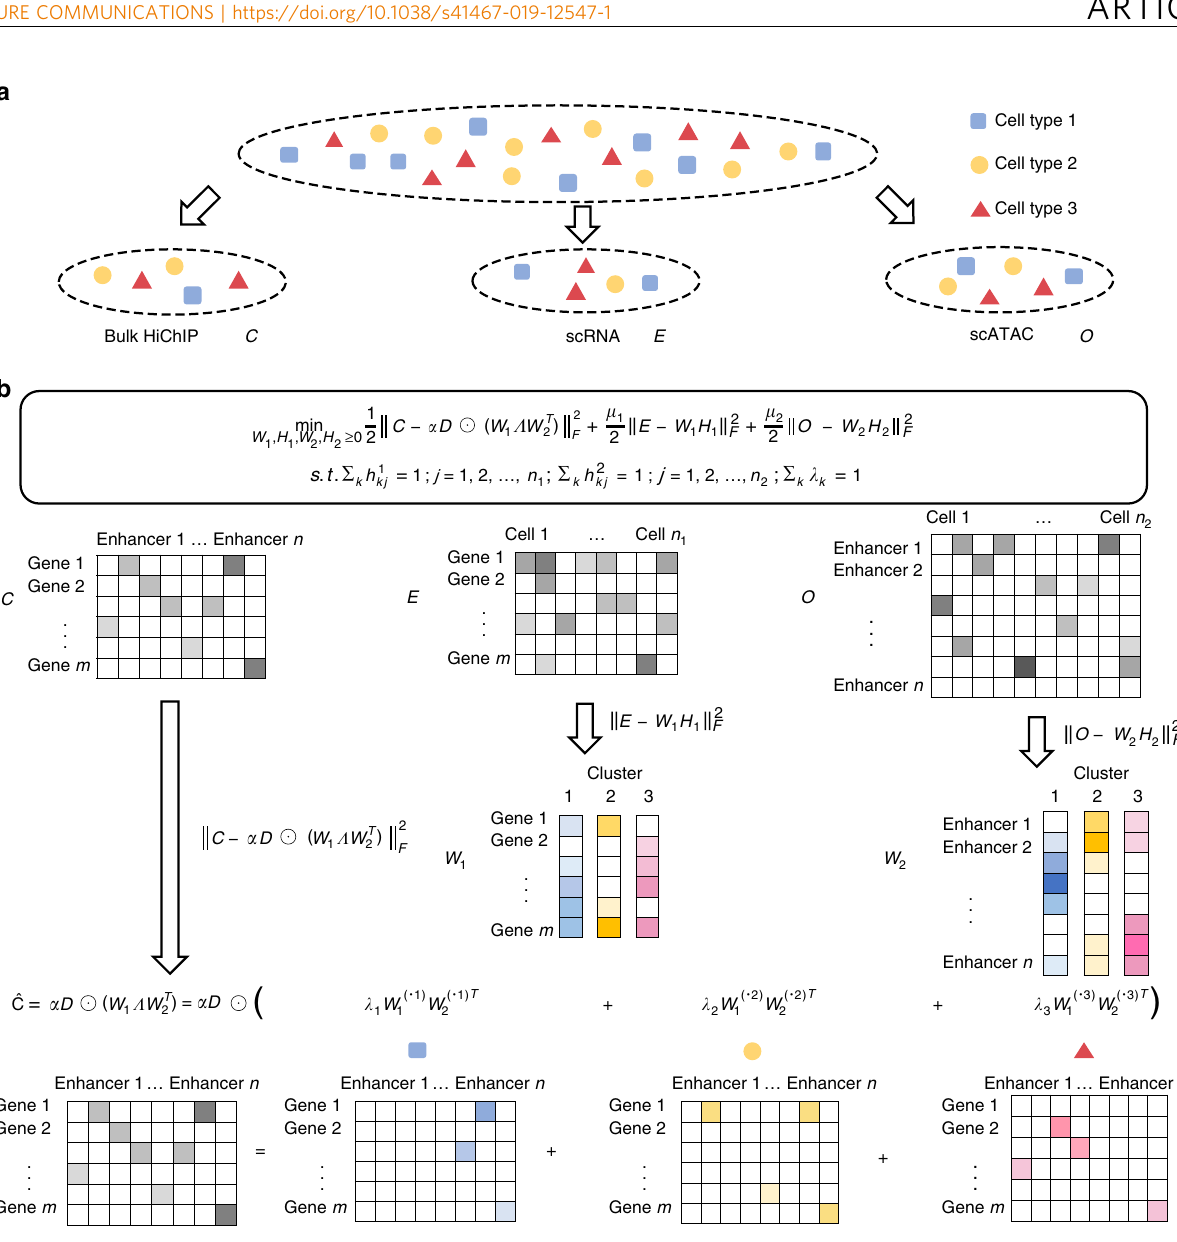
simulated using different dropout rates (Methods). The results were presented in Supplementary Tables 3 – 5. As expected, for all four input settings, deconvolution accuracy deteriorated with increasing dropout rate. When only one data type is available in single cells (input settings 3 and 4) and when the dropout rate is